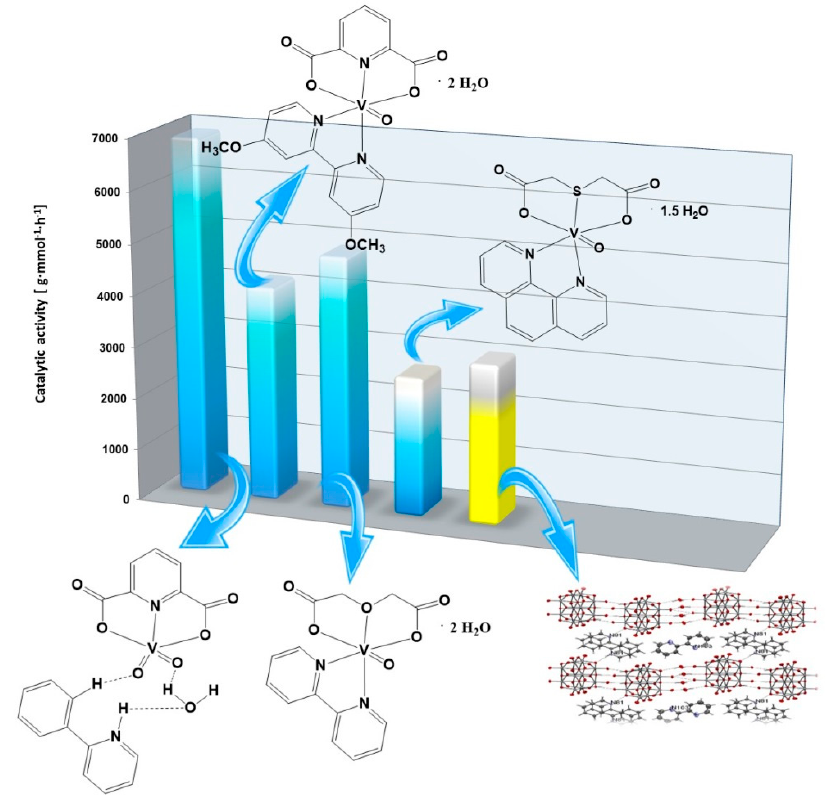
Figure 4. The catalytic activities of vanadium(IV,V) complexes for 2,3-dibromo-2-propen-1-ol oli- gomerization (based on this work and [28]). oligomerization (based on this work and